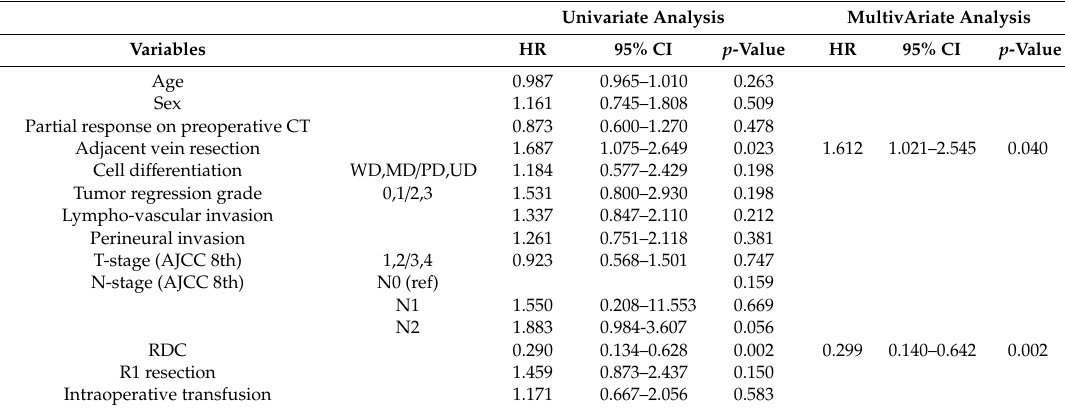
Table 4. Univariate and multivariate analyses of factors associated with recurrence free survival in patients with pancreatic cancer and carbohydrate antigen 19-9 concentrations of 37–1000 U / mL before neoadjuvant